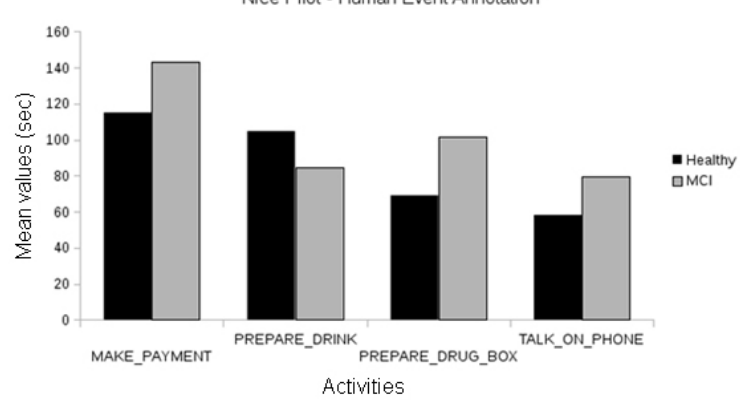
Figure 8. Comparison between the duration of manually annotated events of the different cognitive status groups of the Nice pilot.